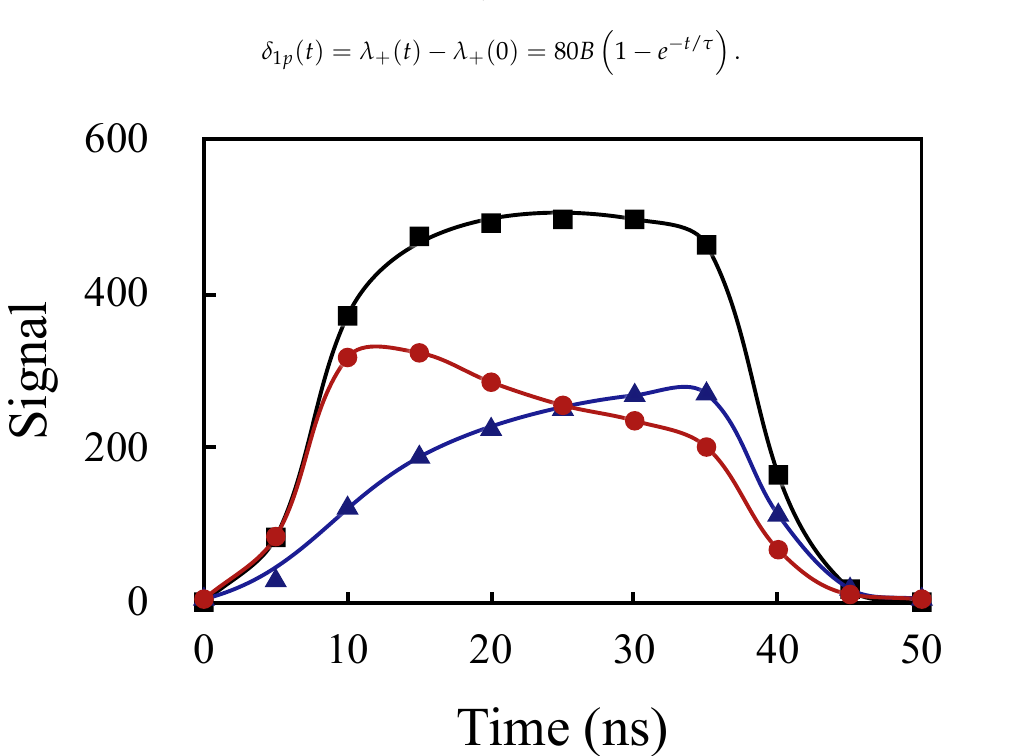
Figure 7. Pulse shape after reflection for three laser diode temperatures corresponding to the center of the grating (squares), and at about half-maximum on both sides (circles and